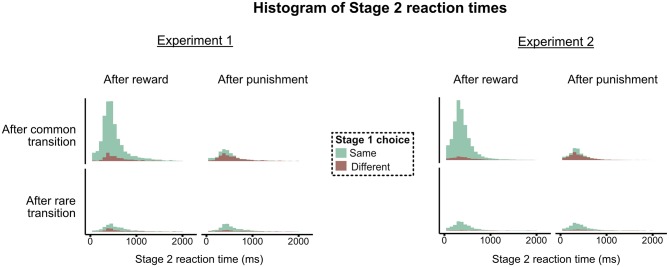
Distribution of Stage 2 reaction times, as a function of the previous trial's transition and reinforcement and the current trial's Stage 1 choice. All distributions were roughly unimodal and right-skewed.